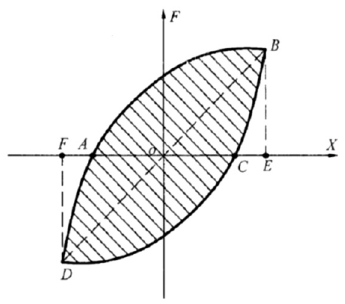
Figure 12. Determination of hysteresis loop area. Table 4. S series joint energy consumption index.